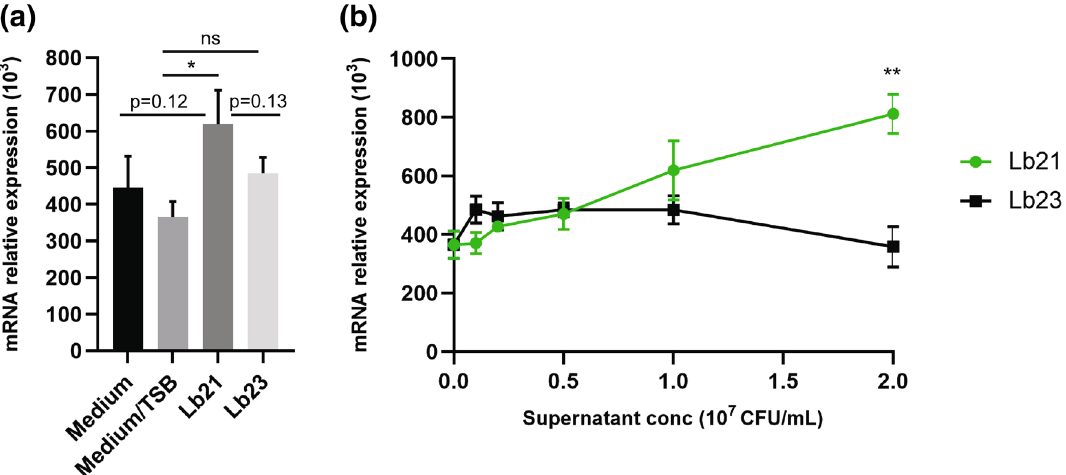
Figure 6. Lb21 but not Lb23 enhanced TGF-β expression of pig epithelial cells (IPEC-J2). Pig epithelial cells (IPEC-J2) were cultured with bacterial supernatant (Lb21 or Lb23, respectively) for 6 h. Cells were then collected and TGF-β mRNA was measured by RT-PCR. The experiments were performed twice with a total of 6 replicates. Data are shown as mean ± SEM. *P < 0.05; **P < 0.01; n.s. not statistically significant. ( a ) The TSB media did not increase TGF-β mRNA. However, the Lb21 supernatant at 10 7 CFU/mL significantly increased TGF-β expression in IPEC-J2 cells. ( b ) TGF-β induction in IPEC-J2 cells by the Lb21 supernatant is dose-